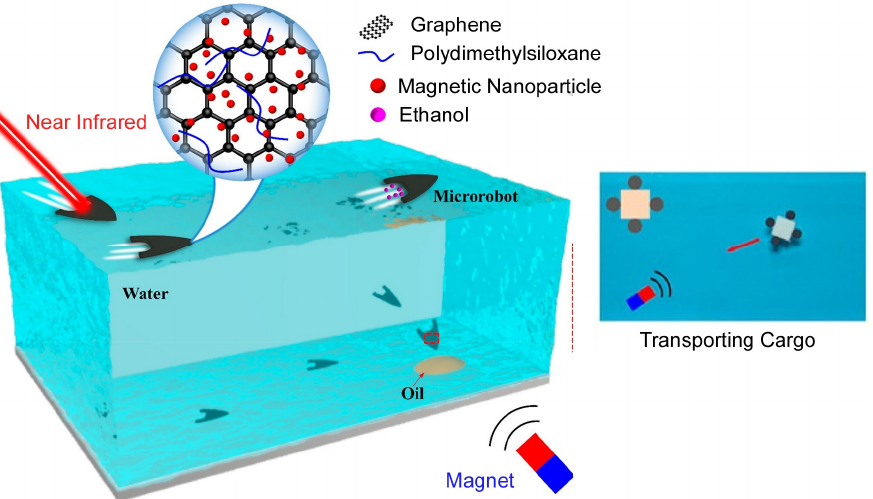
Figure 25. Multi-stimulus-responsive superhydrophobic microrobots that can drift at high speed on water through optical, magnetic, and chemical controls. Reprinted with permission from Reference [201]. Copyright 2022 American Chemical